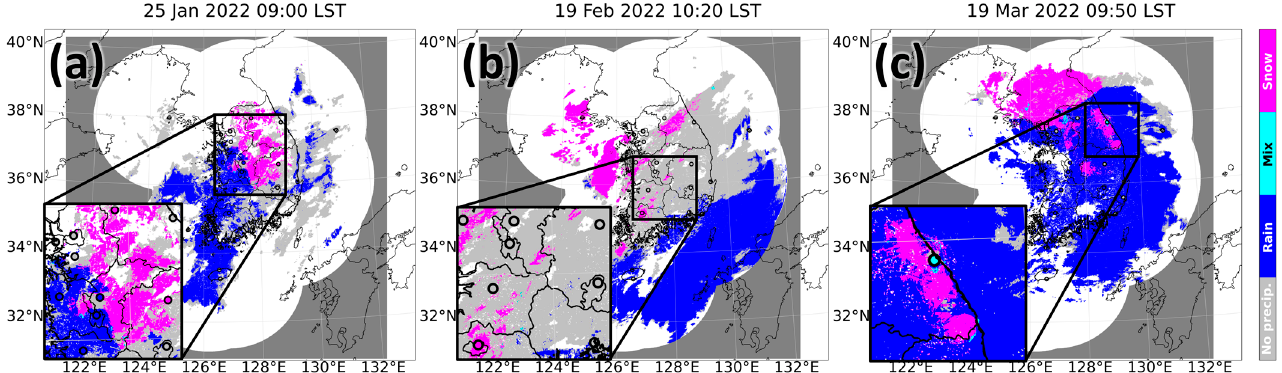
Figure 10. Same as Figure 9 except for cases of the co-occurrence of multiple precipitation types at ( a ) 0900 LST, 25 January 2022, ( b ) 1020 LST, 19 February 2022, and ( c ) 0950 LST, 19 March 2022.